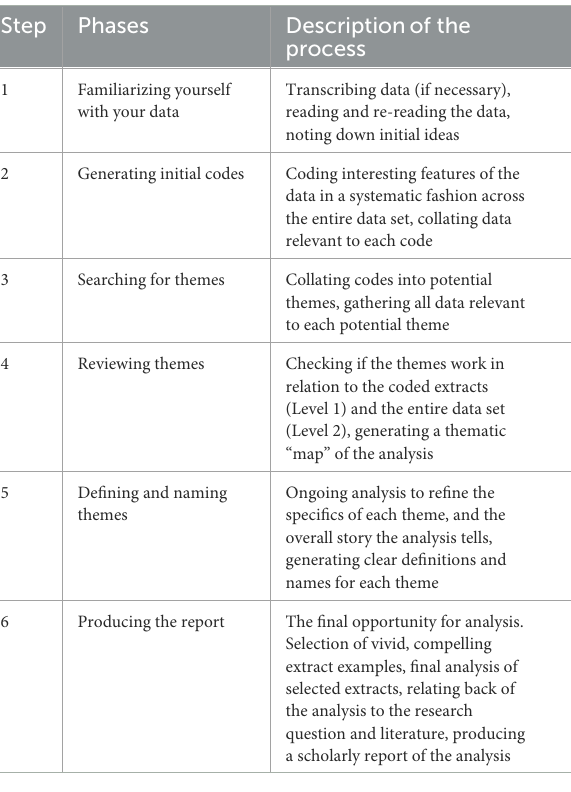
TABLE 1 Phases of thematic